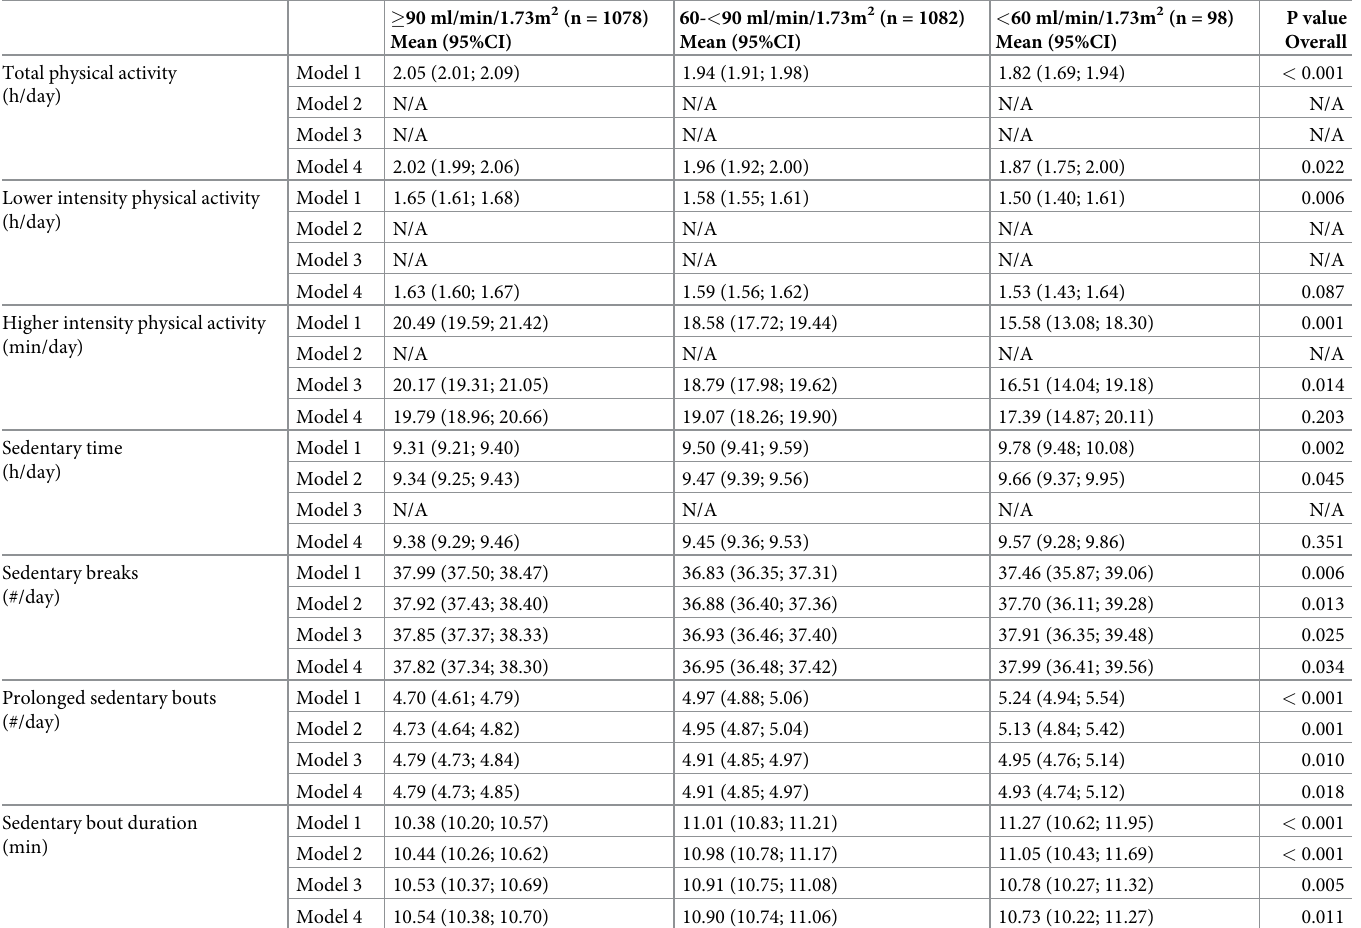
Table 2. Adjusted means of physical activity and sedentary behavior variables according to eGFR crcys